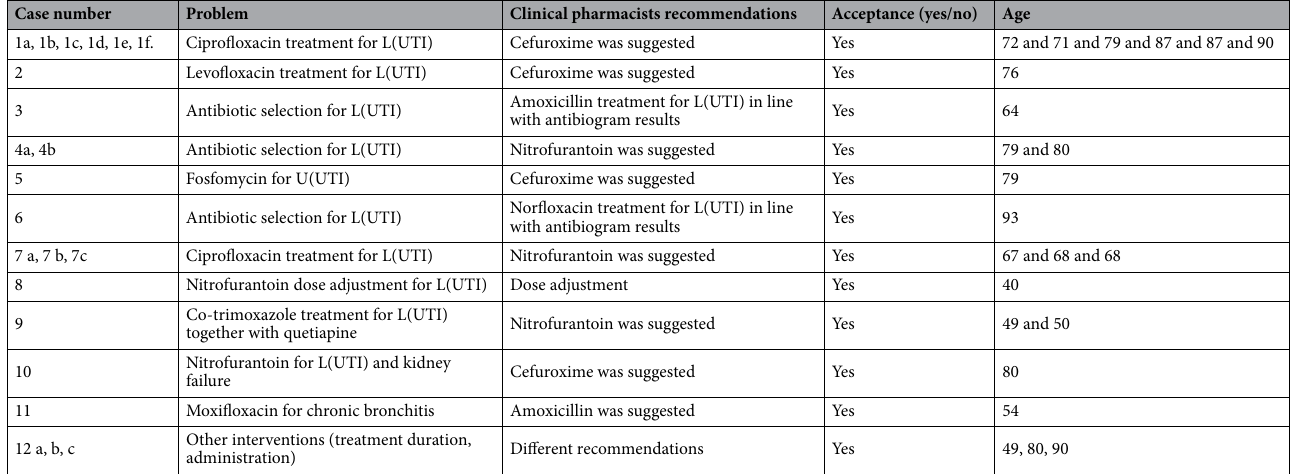
Table 2. Proposed and accepted recommendations in antibiotic therapy; L(UTI): lower urinary tract infection; U(UTI): upper urinary tract